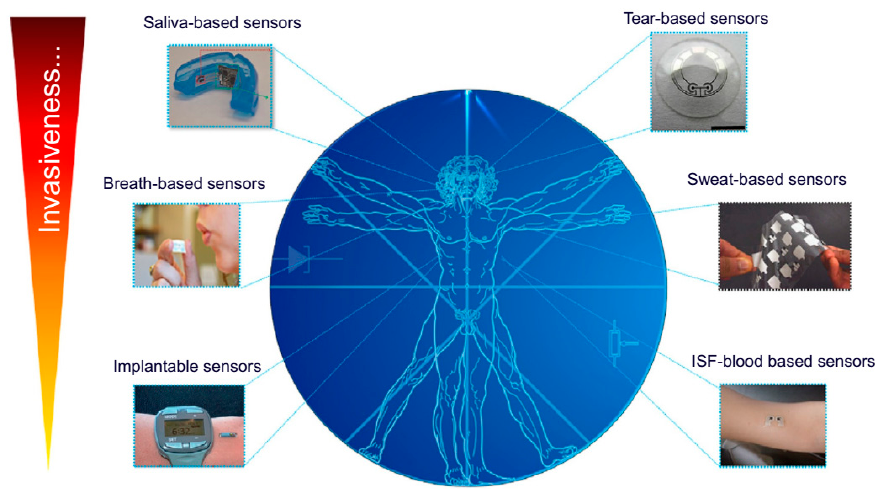
Figure 4. Overview of the rapidly growing field of wearable biosensors (reprint with permission from Pappa A M et al., 2018; Ref. [170]. Copyright 2018 Elsevier Ltd.).